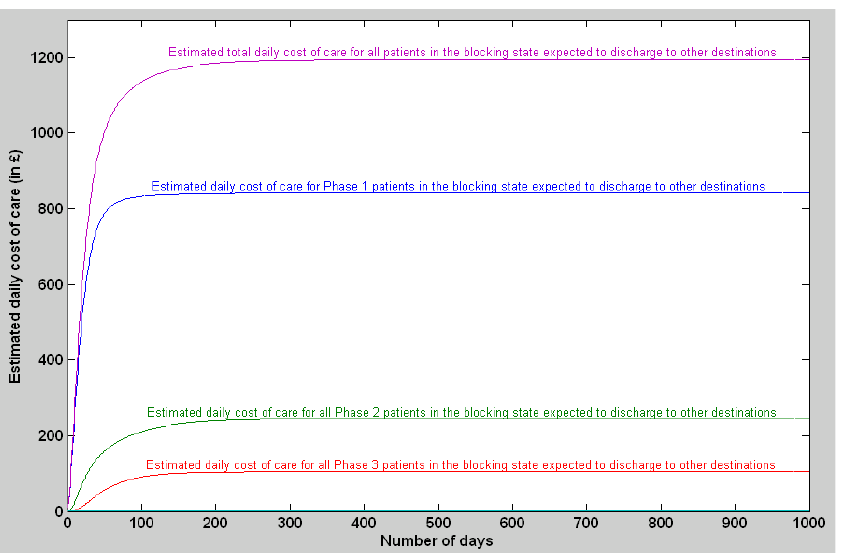
Figure 21. The estimated daily cost of care for patients in the blocking state of each phase expected to be discharged to other destinations (for mean discharge delay τ = 10 days).